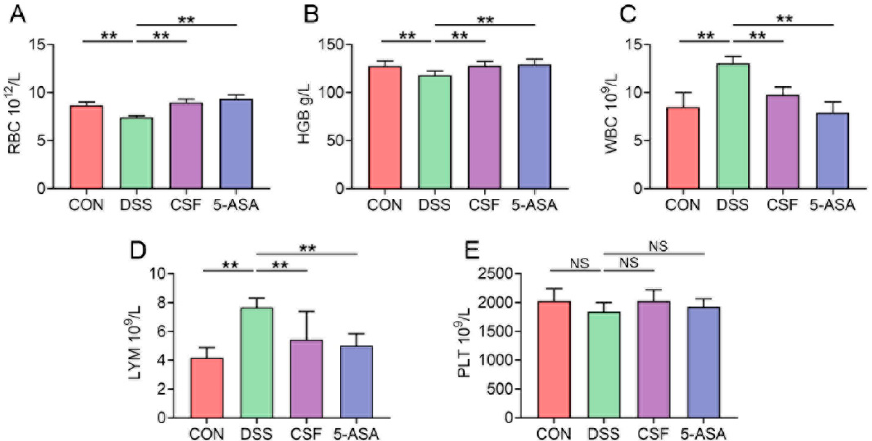
Figure 2. CSF changed the hemogram results of the colitis mice ( n = 8). ( A – E ) The results of red blood cell (RBC) count, haemoglobin (HGB) level, white blood cell (WBC) count, lymphocyte (LYM) count, and platelet (PLT) count of the mice in each group. The data are presented as mean ± SD, ** p < 0.01, NS: no significance.